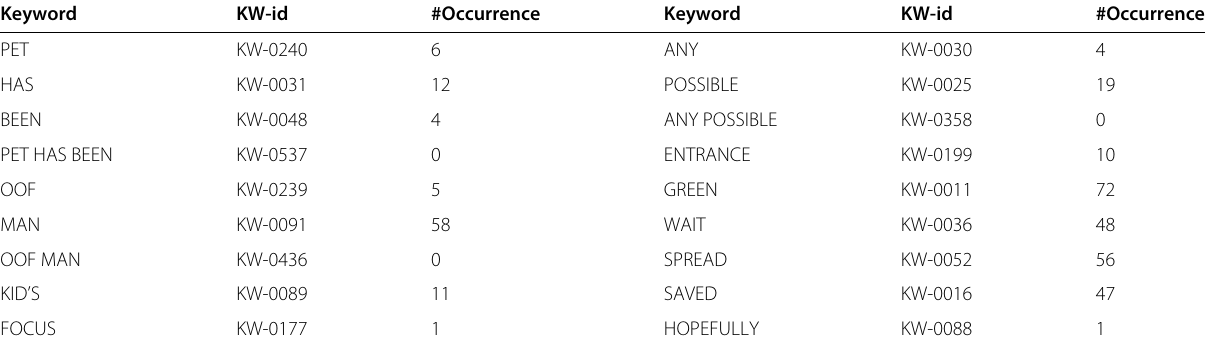
Table 3 Keyword occurrence statistics in training set